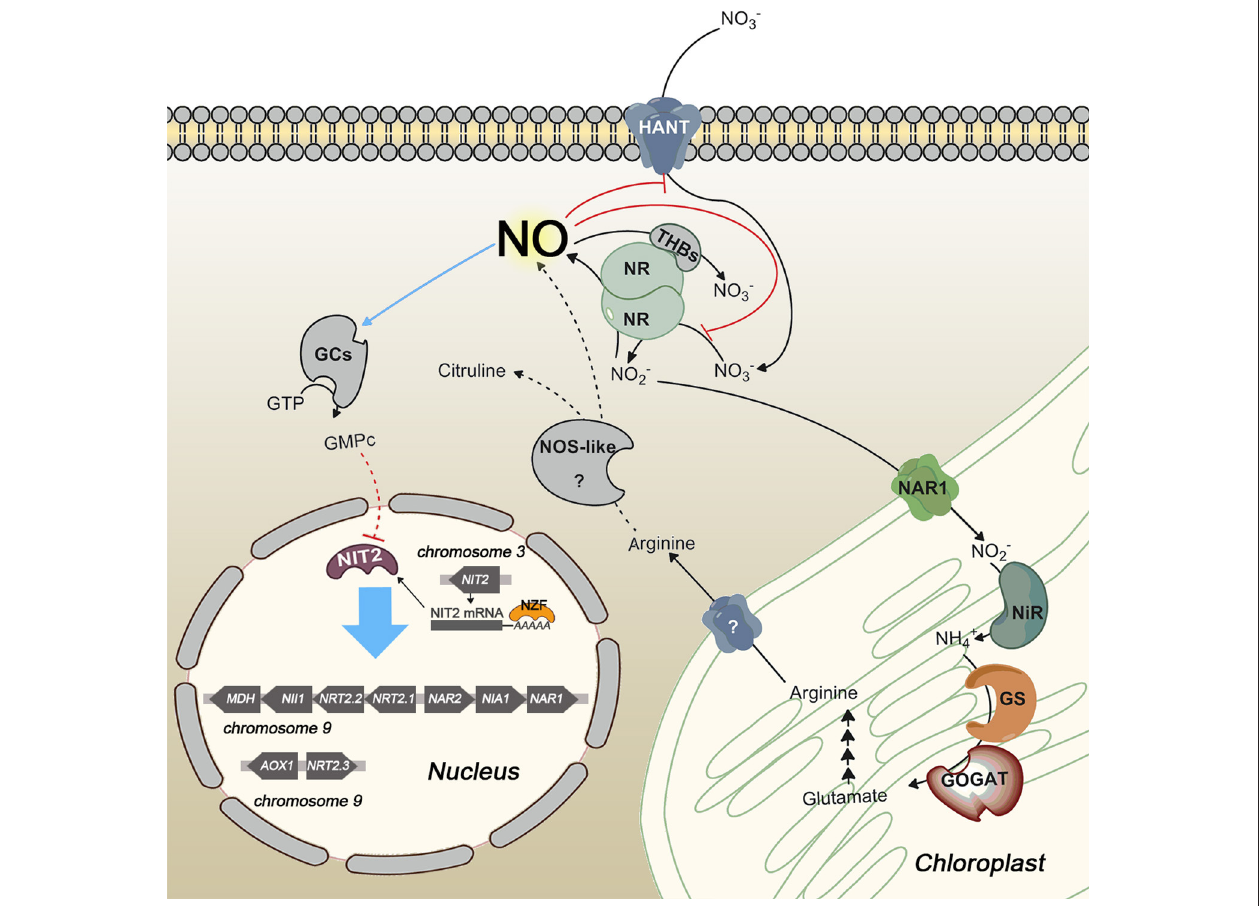
FIGURE 3 | Scheme of transcriptional and posttranslational negative regulation of nitrate assimilation in Chlamydomonas . Red and blue lines indicate inhibition and activation, respectively. Dashed lines represent hypothetic steps. NOS-like protein is an unidentified player that symbolizes the NOS activity reported in photosynthetic organisms. NO represses gene expression by activating a soluble guanylate cyclase (sGC) and inhibits NR activity and high affinity nitrate uptake. Two different sources of NO are represented, NR and a putative NOS enzyme. NO is scavenged by the complex